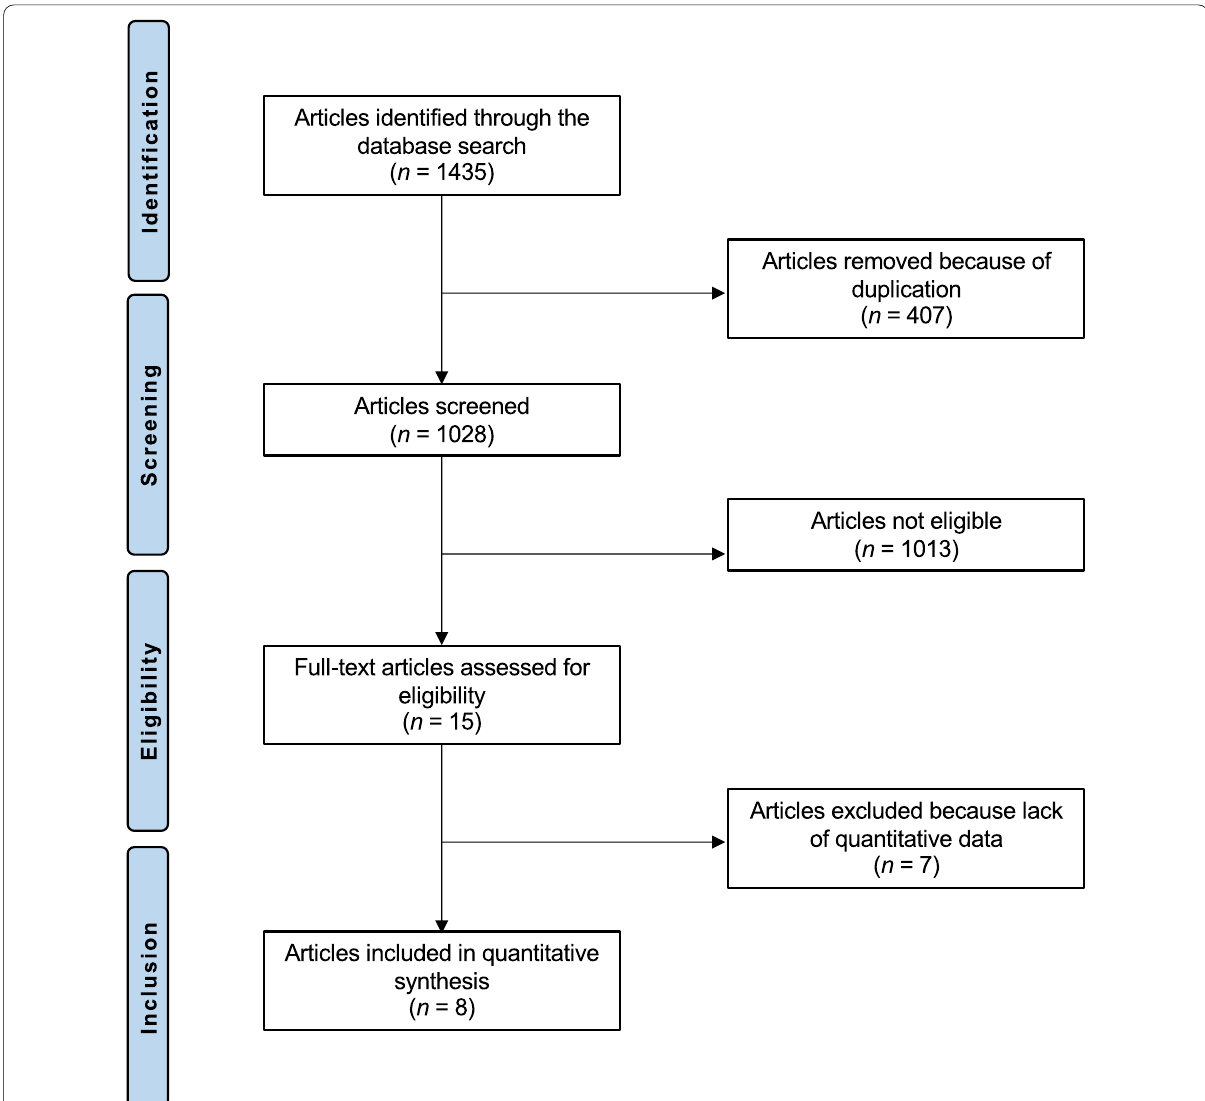
Fig. 1 Flow chart of the literature